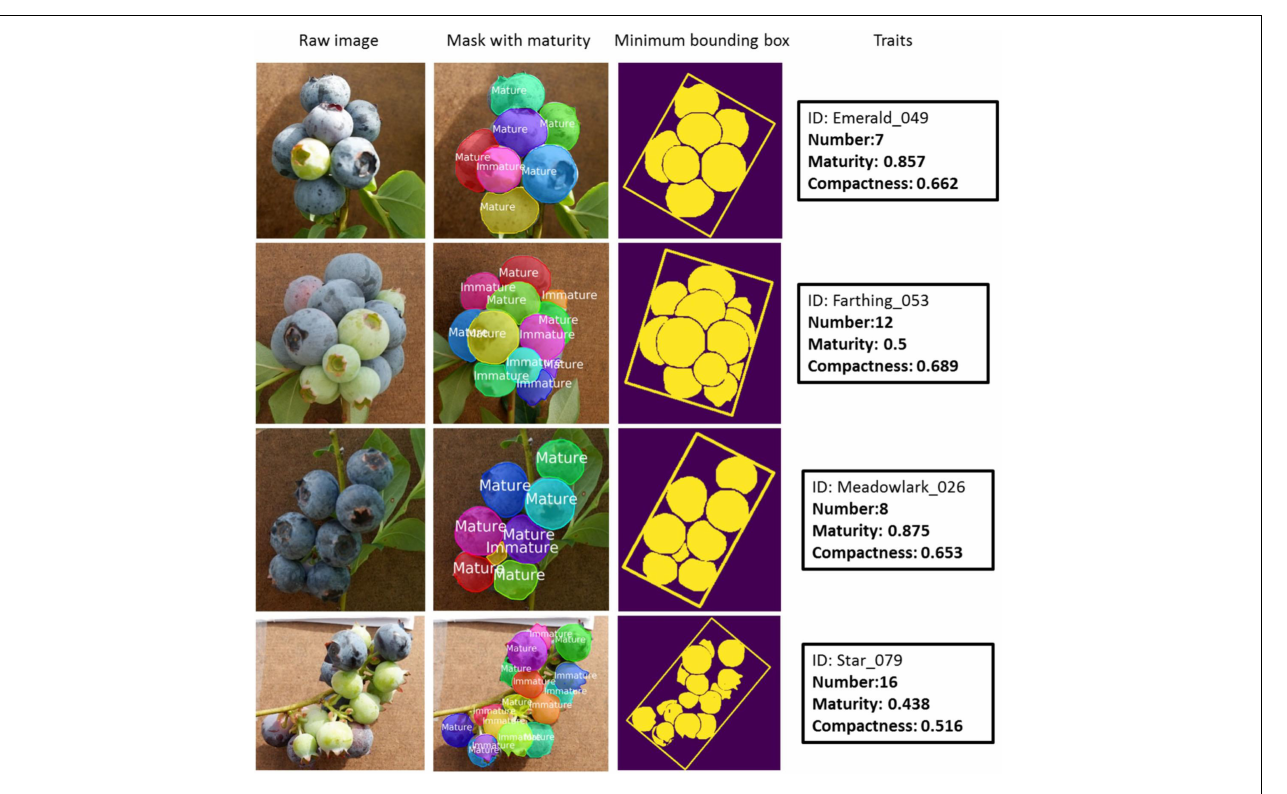
FIGURE 11 | Detection examples in Ni et al. (2020). The black rectangle contains the ID number and three traits (number, maturity, and compactness) of the corresponding